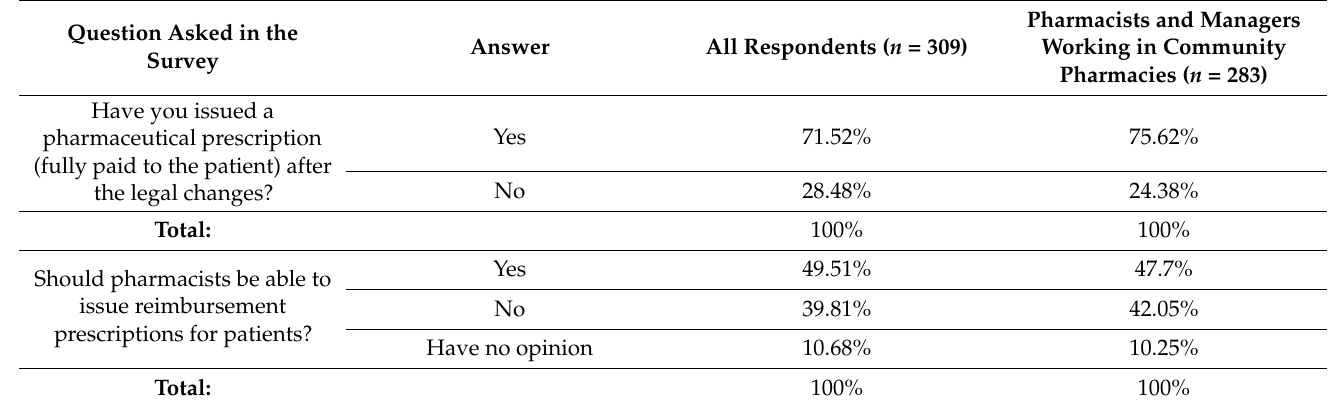
Table 1. Percentage distribution of respondents’ answers to the questions asked in the questionnaire regarding a pharmaceutical prescription issued to a patient in a